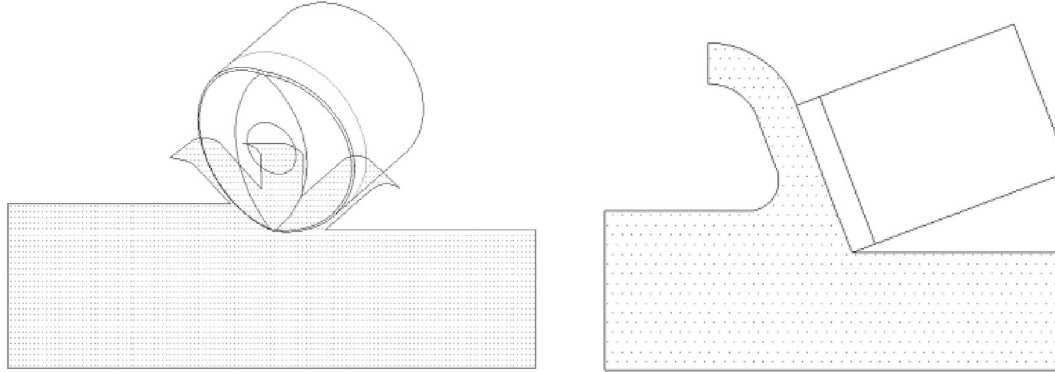
Fig. 2 Cutting shale with a 3D concave-shaped cutter and a flat